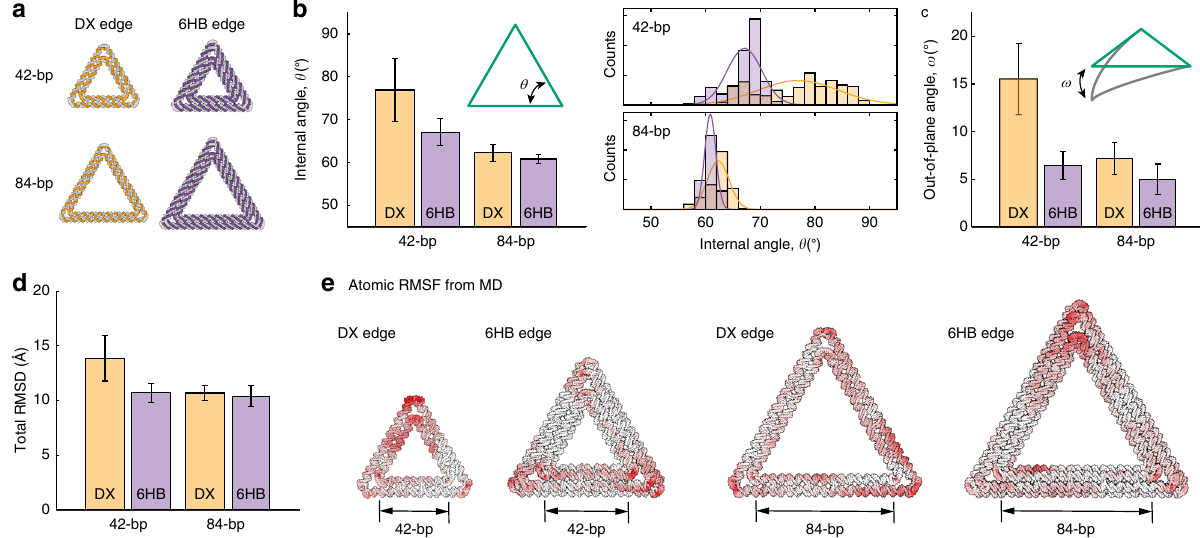
Fig. 4 Molecular dynamics simulations of triangular DNA origami objects. a Two DX- and 6HB-based DNA origami triangular objects are simulated using all-atom molecular dynamics. b The average internal angle, θ , of triangular objects varies with edge base-pair length (42- and 84-bp) and edge-type (DX and 6HB edges). c The average out-of-plane angle, ω , of the DNA origami triangular objects. d Total RMSD of all nucleic acid atoms based on the ground- state atomic model generated by METIS. e All-atom RMSFs are calculated for the 42- and 84-bp DX- and 6HB-based triangular objects and mapped as a white-to-red color gradient. Source Data are available in the Source Data fi Speci fi cally, the internal angle distributions are 76.9 ± 7.3°, 67.1 ±